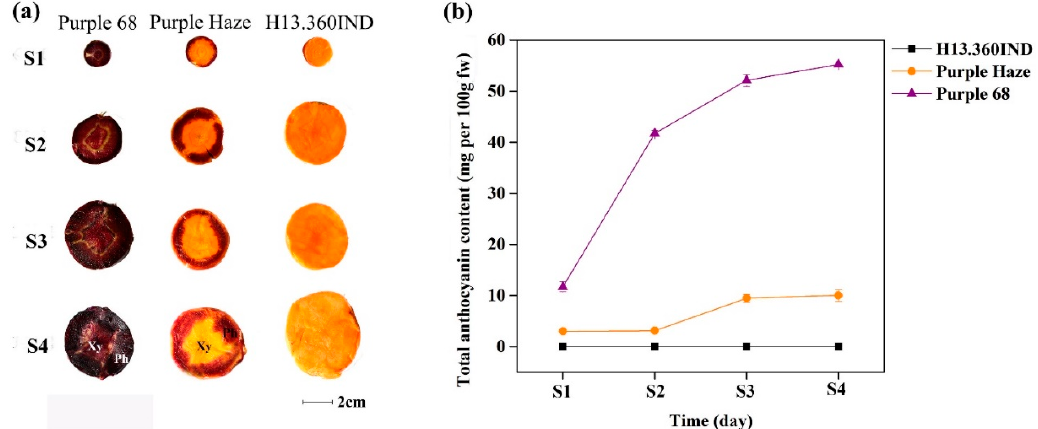
Figure 1. Differential pigment accumulation analysis in three carrot cultivars (‘Purple 68 ′ , ‘Purple Haze’ and ‘H13.360IND’). ( a ) Four growth stages of three carrot cultivars. S1, S2, S3, and S4 represent 4 growth stages of harvested carrots at 60, 80, 100 and 120 days after sowing, respectively. Xy and Ph represent xylem and phloem, respectively. ( b ) Total anthocyanin content in four growth stages. The data were expressed as mg of cyanin equivalents per g fresh weight.